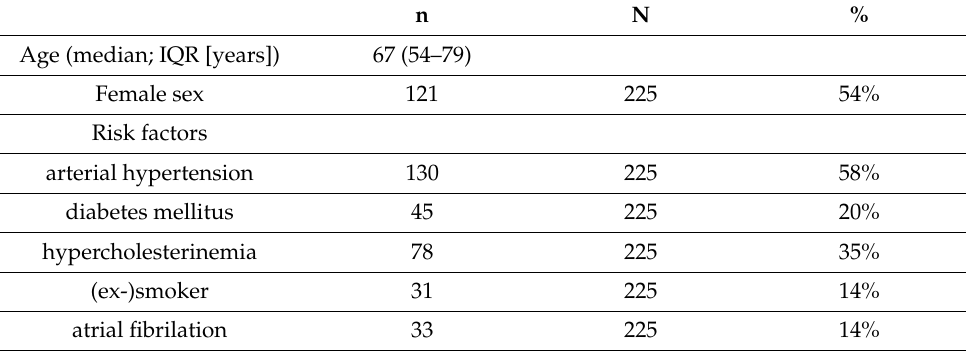
Table 1. Patients characteristics on acute ischemic stroke admitted in the participating hospitals and treated with.v. tPA treatments from 2016 to first quarter